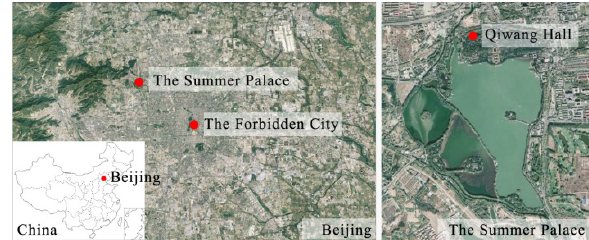
Figure 1. The location of Qiwang Hall